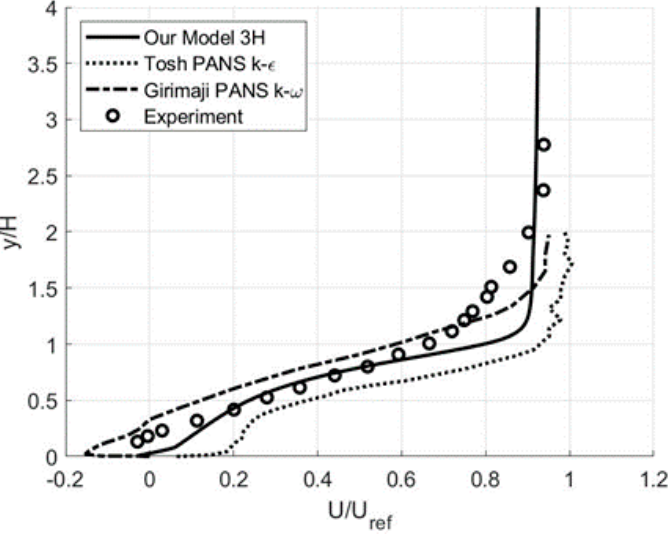
= 5 from the step (𝑓 (cid:3084) = 0.667,𝑓 (cid:3038) = 0.2).